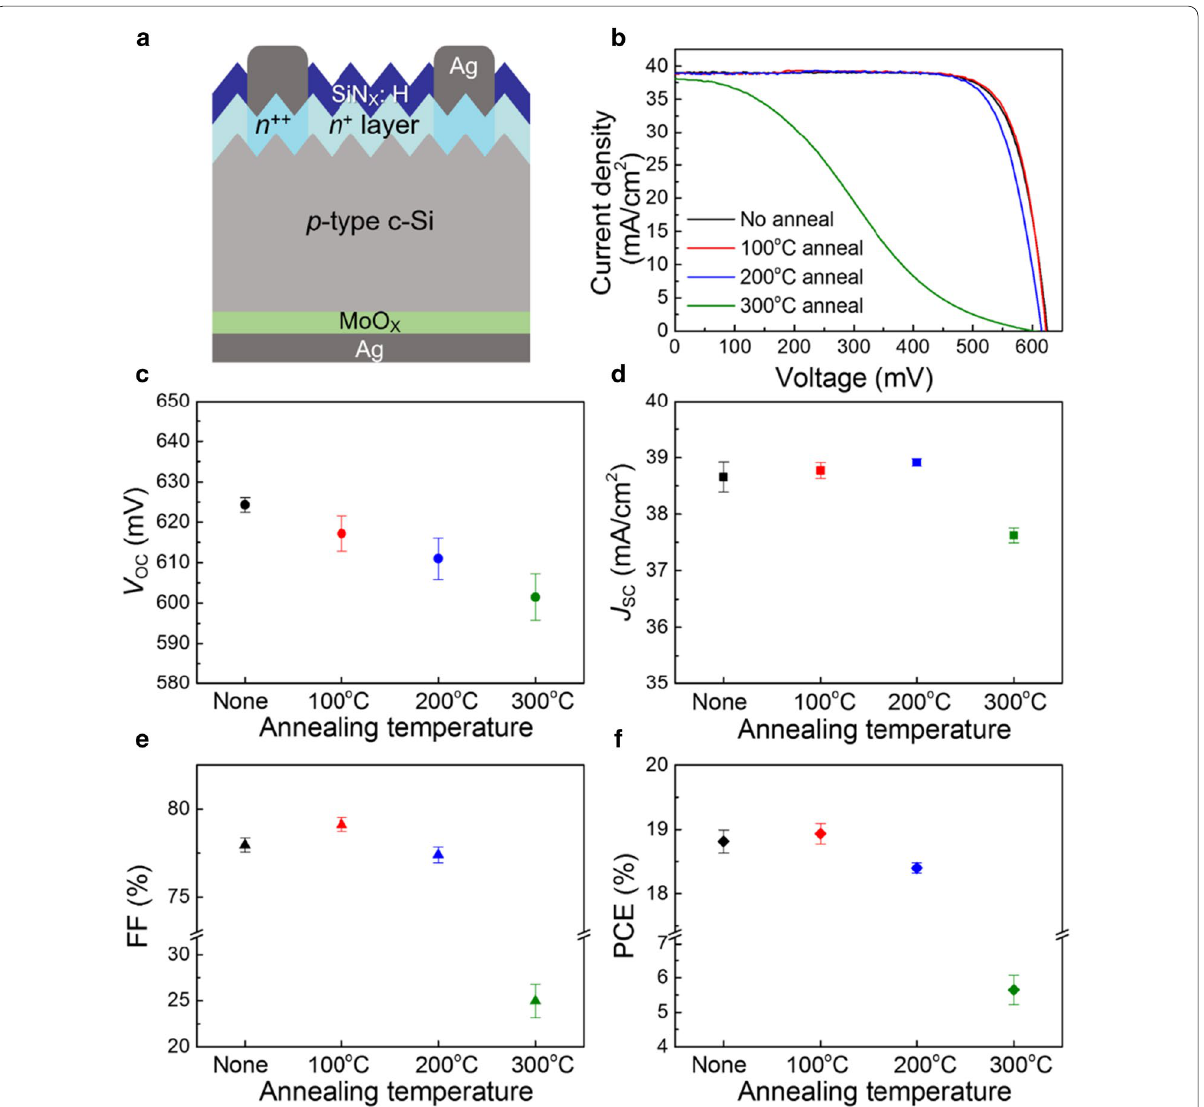
Fig. 7 a Cross-sectional schematic, b J–V curves and c–f average J–V parameters of the p -Si/MoO X /Ag solar cells with MoO X films annealed at different